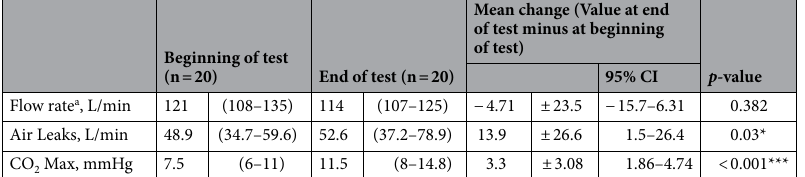
Table 4. Ventilator parameters and measured maximum carbon dioxide tension. Data are presented as mean ± SD or median (IQR). * p < .05; *** p < .001. a Measured when the flow rate was at the peak inspiratory pressure; CO 2 Max: maximum carbon dioxide